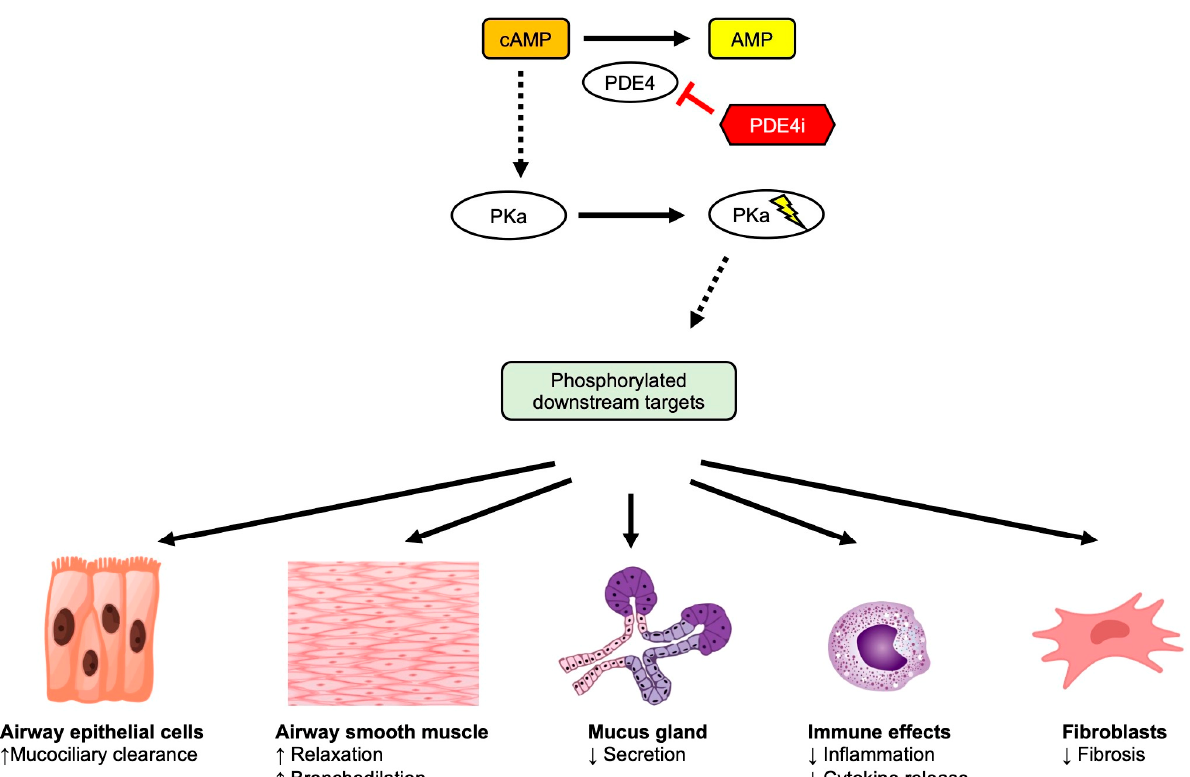
Figure 3. Beneficial effects of PDE4 inhibition in airway diseases. Adapted from Contreras et al., 2017 [62] and Joskova et al., 2020 [63]. (c)AMP, (cyclic) adenosine monophosphate; PDE4(i), phosphodiesterase-4 (inhibitor); PKa, protein kinase A.